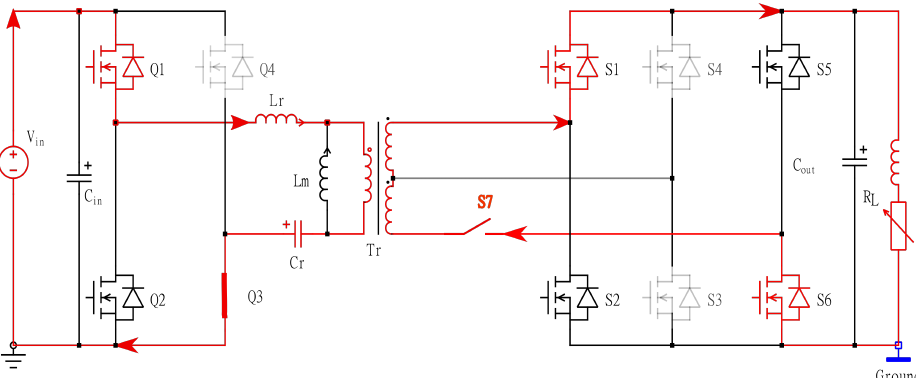
Figure 4. Fault-case: direction of current flow during positive excitation voltage on the resonant network.